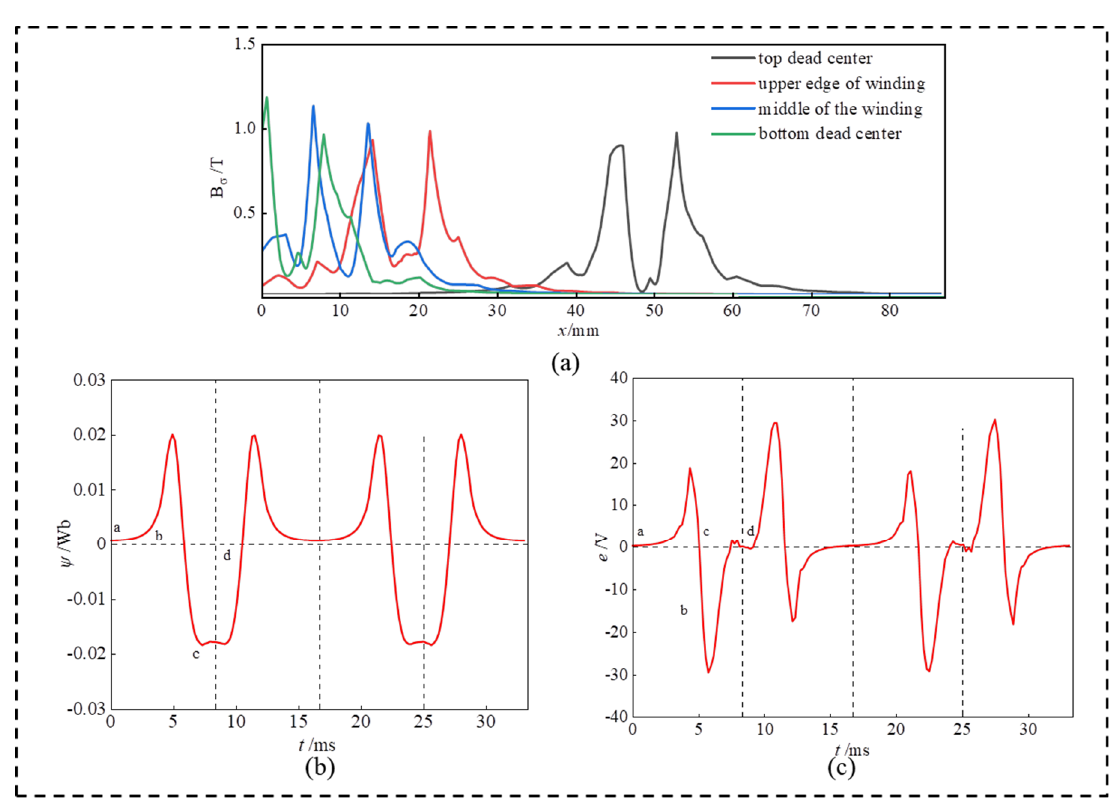
Figure 6. No-load simulation results: ( a ) air gap magnetic density curve; ( b ) magnetic chain change curve; ( c ) electric potential variation curve.